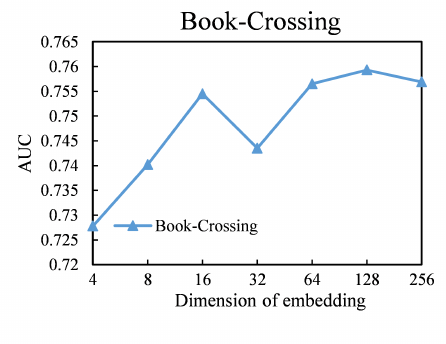
Figure 3. Comparison of the AUC performance on different embedding dimensions in Last.FM.